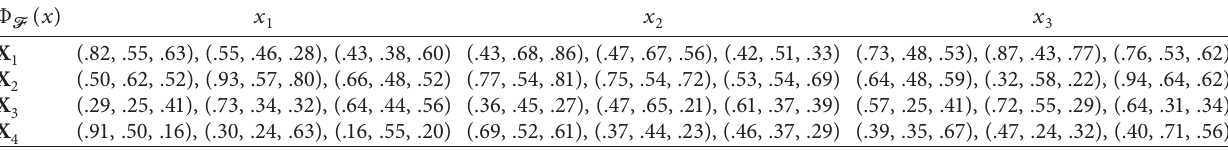
Table 3: Construction of G3-PNSS of all scholars according to department requirement.